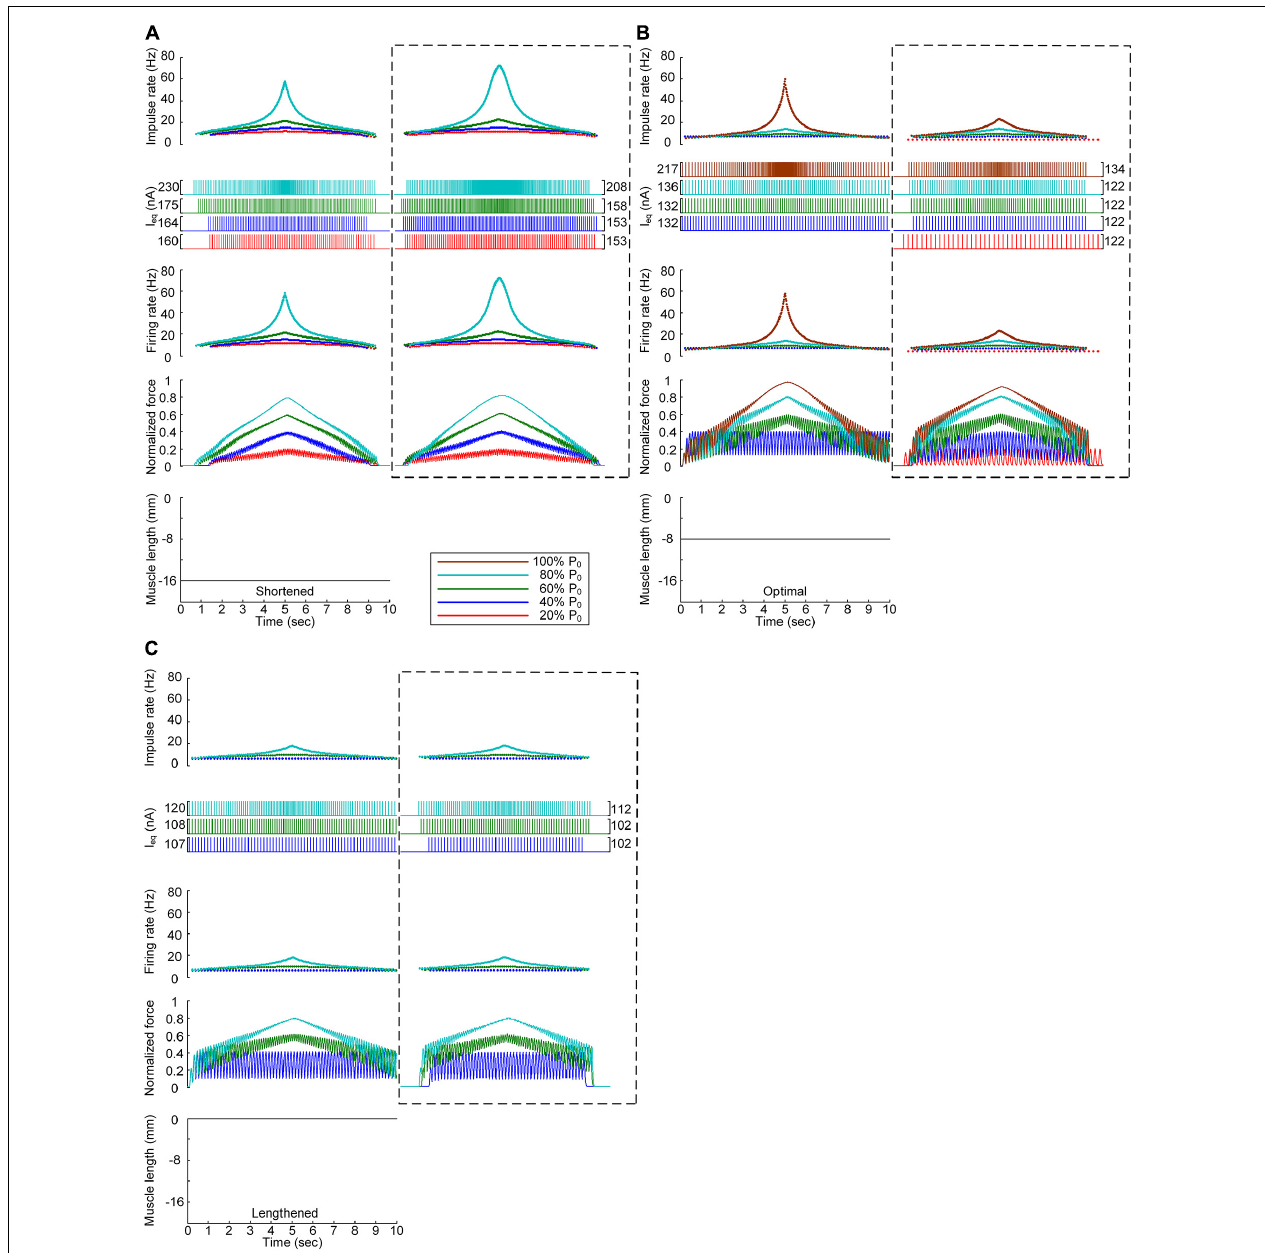
FIGURE 6 | Influence of the PIC on the stimulation waveforms under discrete conditions. Frequency and amplitude (two top panels ) of impulse current stimulation (I eq ) applied to the somatic compartment, instantaneous firing rate ( upper middle ) in the motoneuron, and normalized muscle force ( lower middle ) produced by the muscle unit at the three muscle lengths ( bottom ): physiologically minimum (A) , optimal (B) , and maximum muscle lengths (C) . The level of force production by the motor unit is denoted as a percentage of the maximal isometric force (P 0 ) at the optimal muscle length and indicated with different colors. The dashed-line rectangles indicate the simulation results with the motoneuron PIC channels, as shown in Figure 4 , for the purpose of comparison.